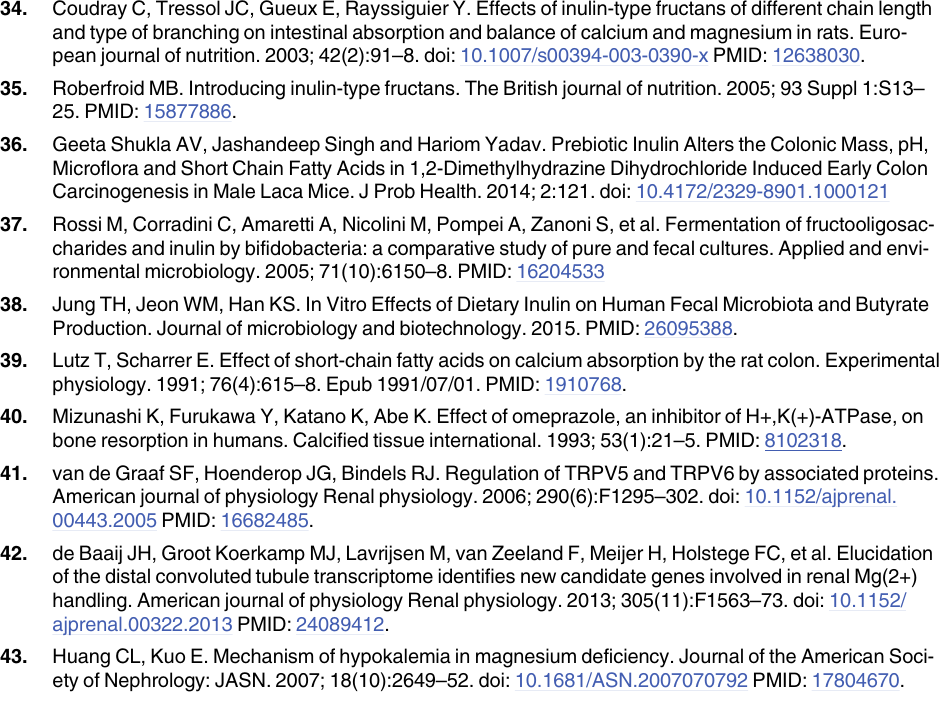
PLOS ONE | DOI:10.1371/journal.pone.0138881 September 23,